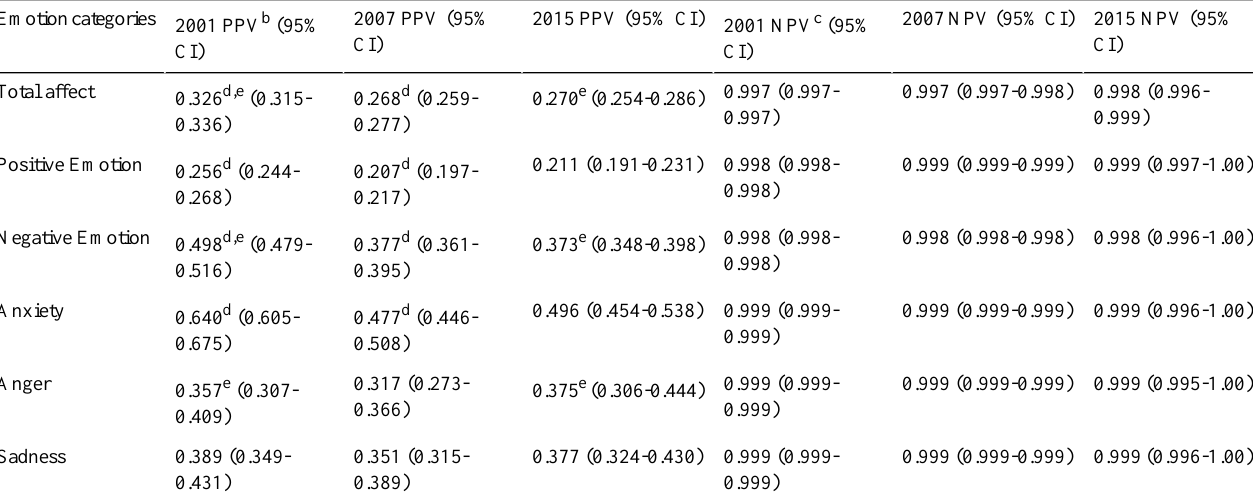
Table 5. Linguistic Inquiry and Word Count 2001, 2007, and 2015 positive predictive value and negative predictive value with 95% CI (N=63) a .